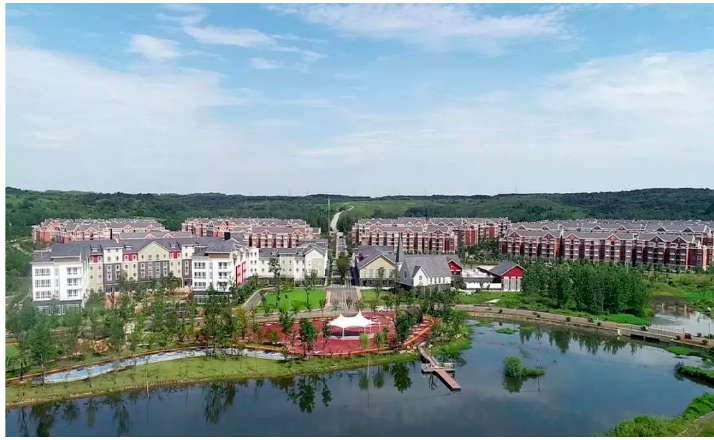
Figure 5. The picture of Tianquan Community.